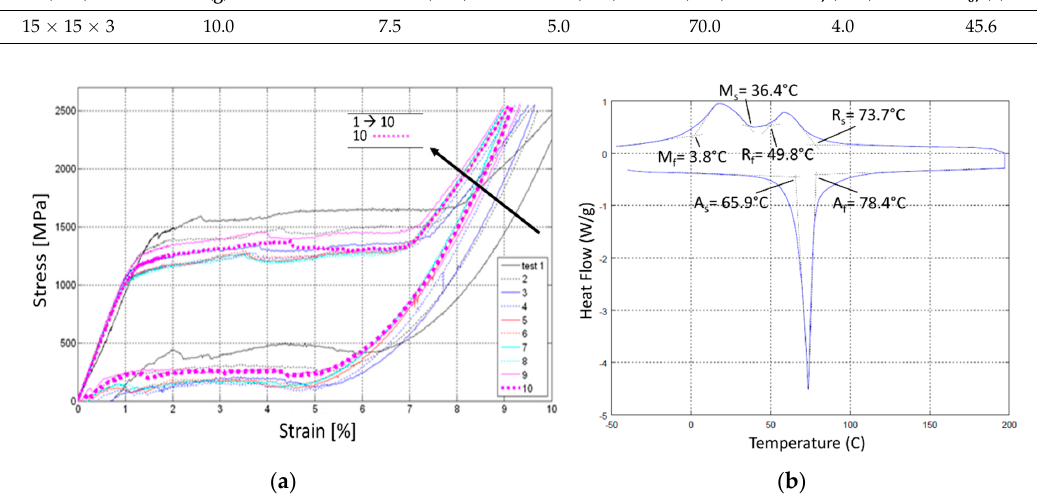
Figure 8. SMA spring material characterization: tensile cycles ( a ); and Differential Scanning Calorimetry, DSC, measurements ( b ).